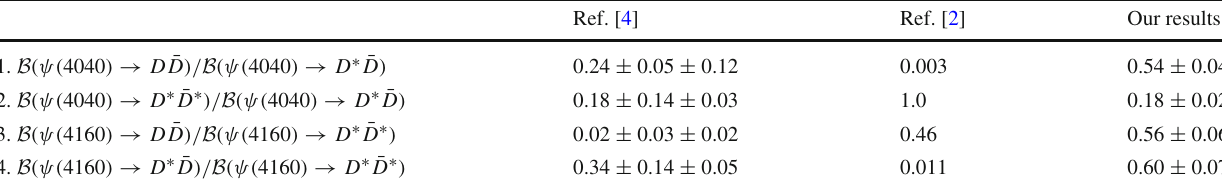
Table 3 Ratios of branching fractions for the ψ( 4040 ) and ψ( 4160 )